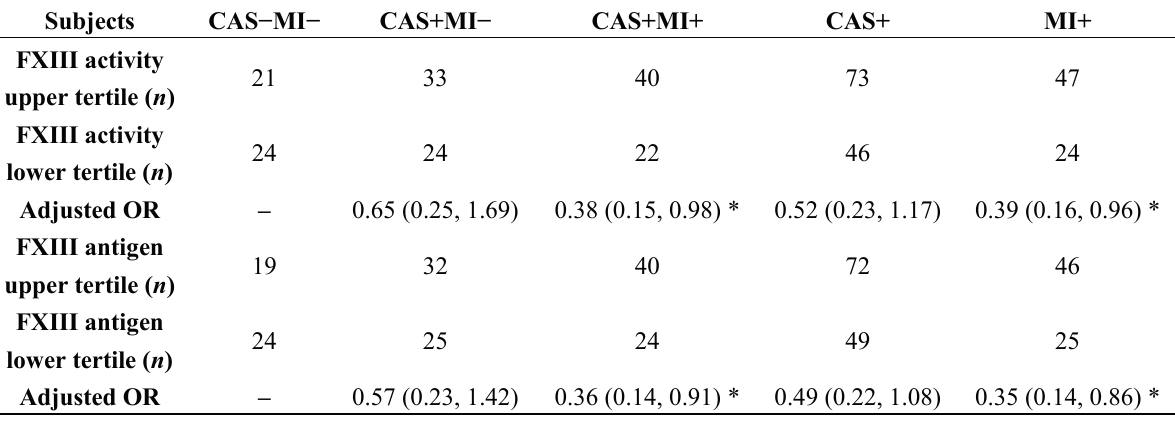
Table 6. The effect of FXIII levels in the lower tertile on the risk of CAD in patients with an elevated fibrinogen